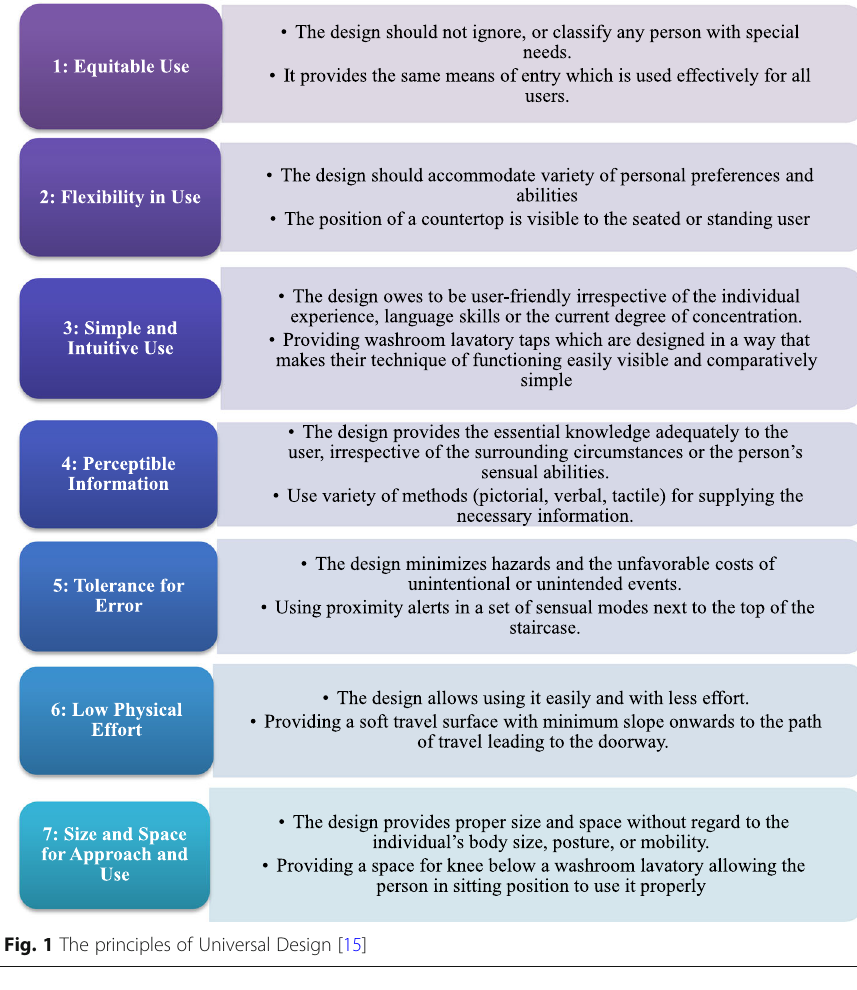
Fig. 1 The principles of Universal Design [15]